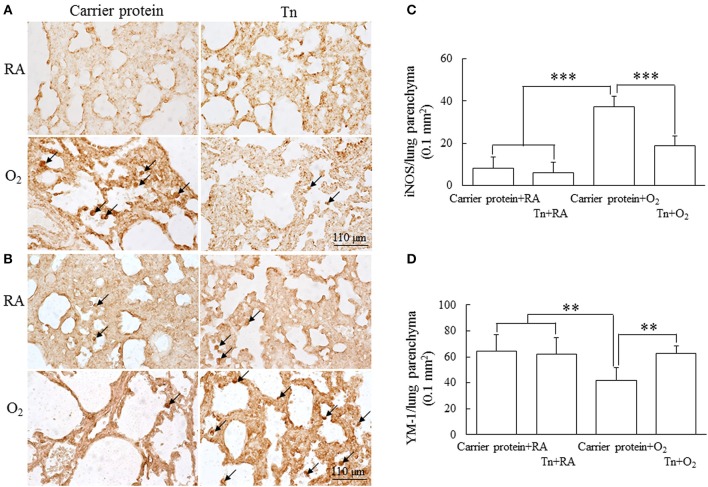
(A,B) Representative immunohistochemistry and (C,D) quantitative analysis of iNOS and Ym1 positive cells in 14-day-old rats in the carrier protein + RA, Tn vaccine + RA, carrier protein + O2, or Tn vaccine + O2 group. The rats in the carrier protein + O2 group exhibited a significantly higher M1 phenotype (iNOS) macrophages (arrow) and lower M2 phenotype (Ym-1) macrophages than those in the carrier protein + RA or Tn vaccine + RA group. Maternal Tn immunization reversed the hyperoxia-induced M1/M2 macrophage polarization to normoxia levels. **p < 0.01, ***p < 0.001.